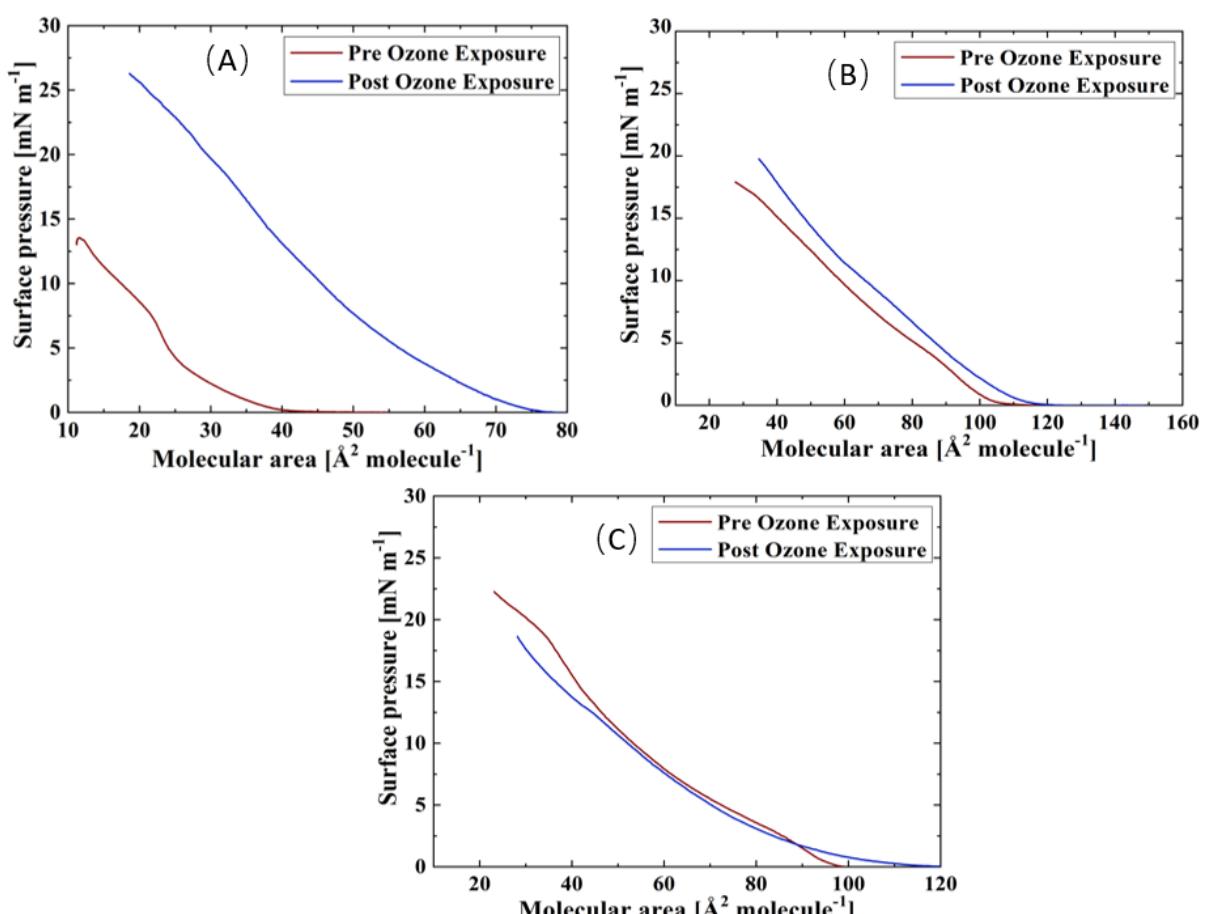
Figure 2. Isotherms of ( A ) CO:PC; ( B ) CO:GT:PC (top, right); and ( C ) CO:GT:FFA:PC (bottom) before ozone exposure (red) and after ozone exposure (blue) on PBS at 22 °C.